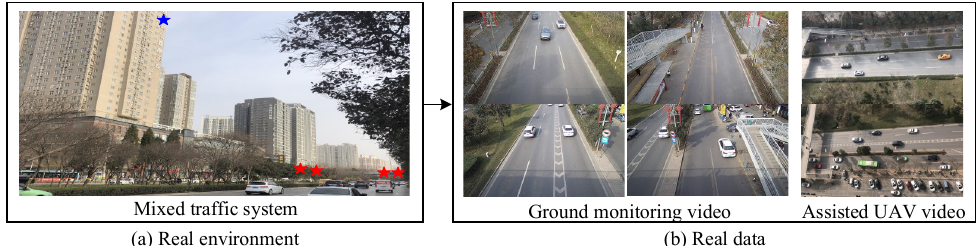
Figure 8. Our self-built database in real scene. ( a ) Real environment. It is a mixed traffic system with bidirectional six-lane main road and bidirectional four-lane side road. The stars represent UAV and ground camera’s general locations. ( b ) Real data. the ground monitoring videos and the UAV videos captured from real